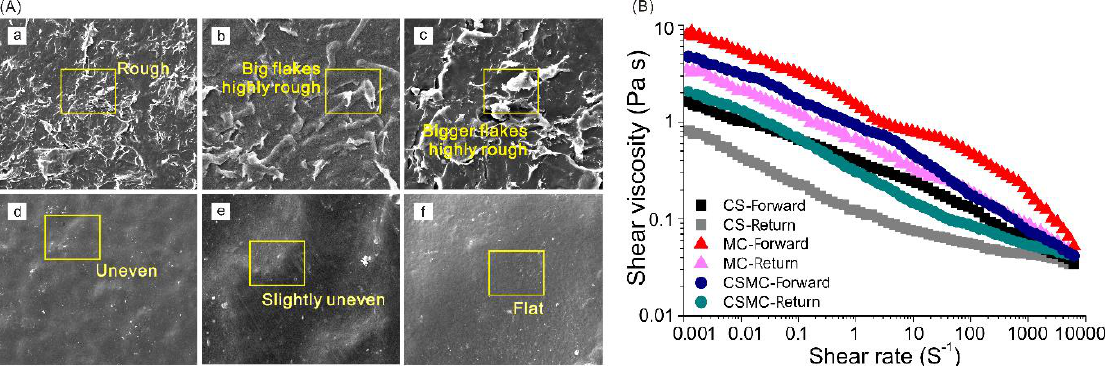
Figure 3. ( A ) SEM micrographs of the prepared films. a, CSF; b, CSMCF1; c, CSMCF2; d, CCSF; e, CCSMCF1; f, CCSMCF2. The scale bar is 500 µ m. ( B ) Shear viscosity of the CS, MC, and CSMC solutions.